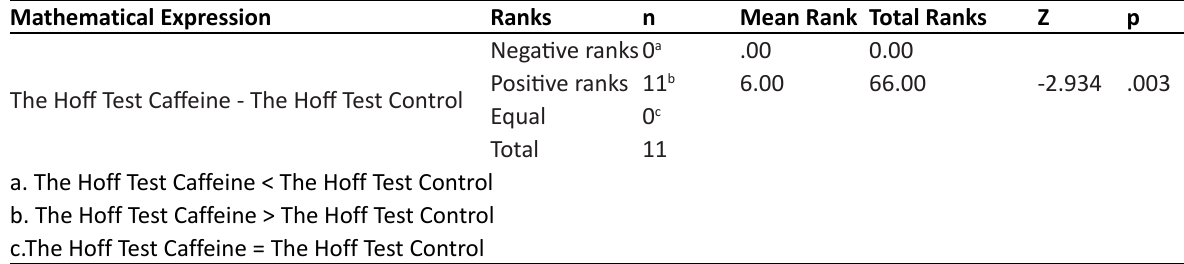
Table 5: Wilcoxon Signed Rank Analysis Results of Caffeine and Placebo Application (The Hoff Test) Mathematical Expression